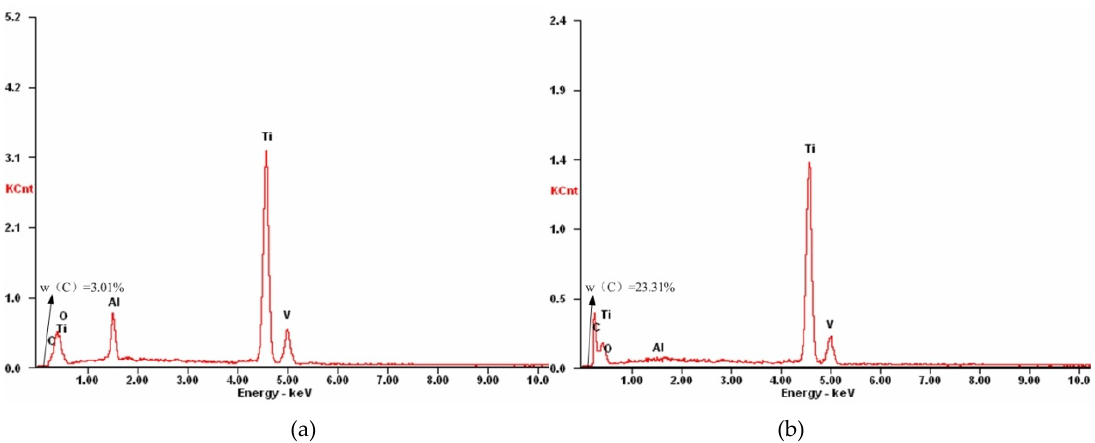
Figure 2. EDS analytical results of the titanium alloy sample surfaces before and after heated test in argon. ( a ) Before experiment; ( b ) after experiment.